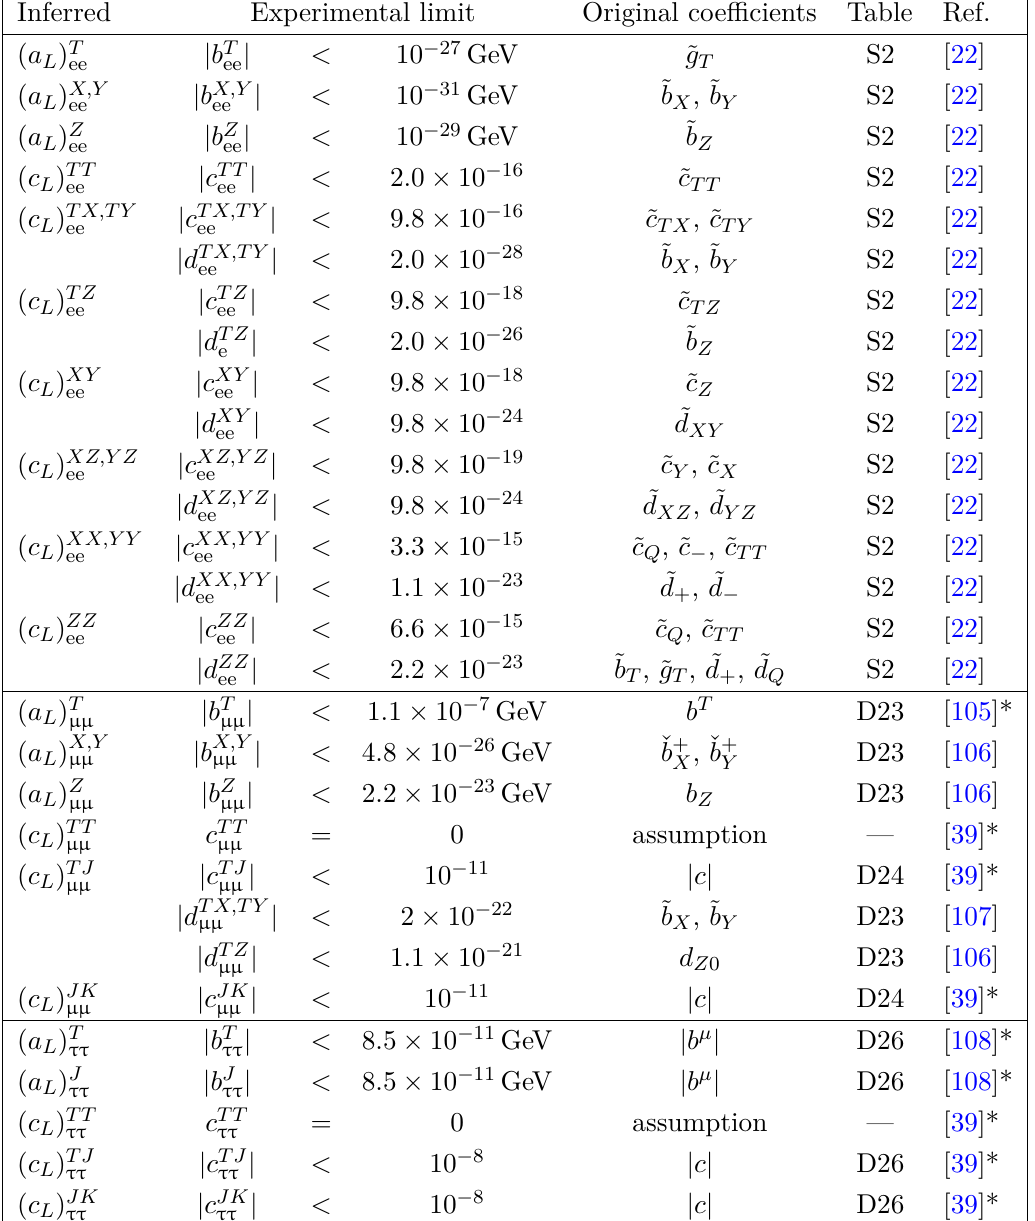
Table 5 . Neutrino coefficients, on which new constraints can be inferred (first column), coefficients in the charged-lepton sector from which the constraints were inferred (second column) along with the particular coefficients (third column) and tables (fourth column) of ref. [22] that the values were deduced from, and the original references (fifth column). Whenever possible, summary table entries were prioritised over data table entries and bounds from pure laboratory experiments were prioritised over astrophysical limits. Theory papers are indicated by an asterisk. Furthermore, J , K are generic spacelike indices. To avoid unnatural cancelations between coefficients, we chose suitable combinations of lower and upper limits. For example, in md ZZ = (˜ b T − ˜ g T + ˜ d + − ˜ d Q ) / 2 we employed lower limits on ˜ g T , ˜ d Q to obtain upper limits on d ZZ . Otherwise, from the existing positive numbers in table S2 of ref. [22] we would have immediately deduced that d ZZ = 0 for